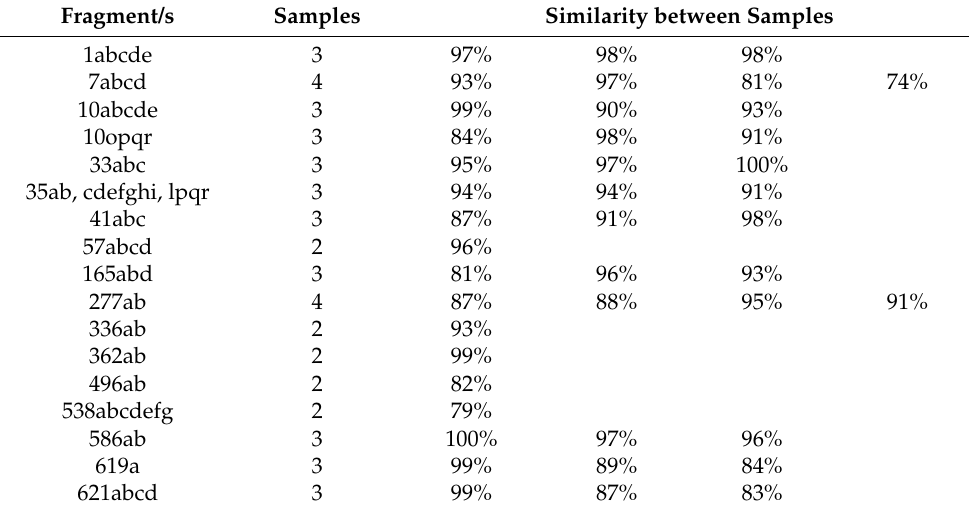
3 99% 89% 84% 621abcd 3